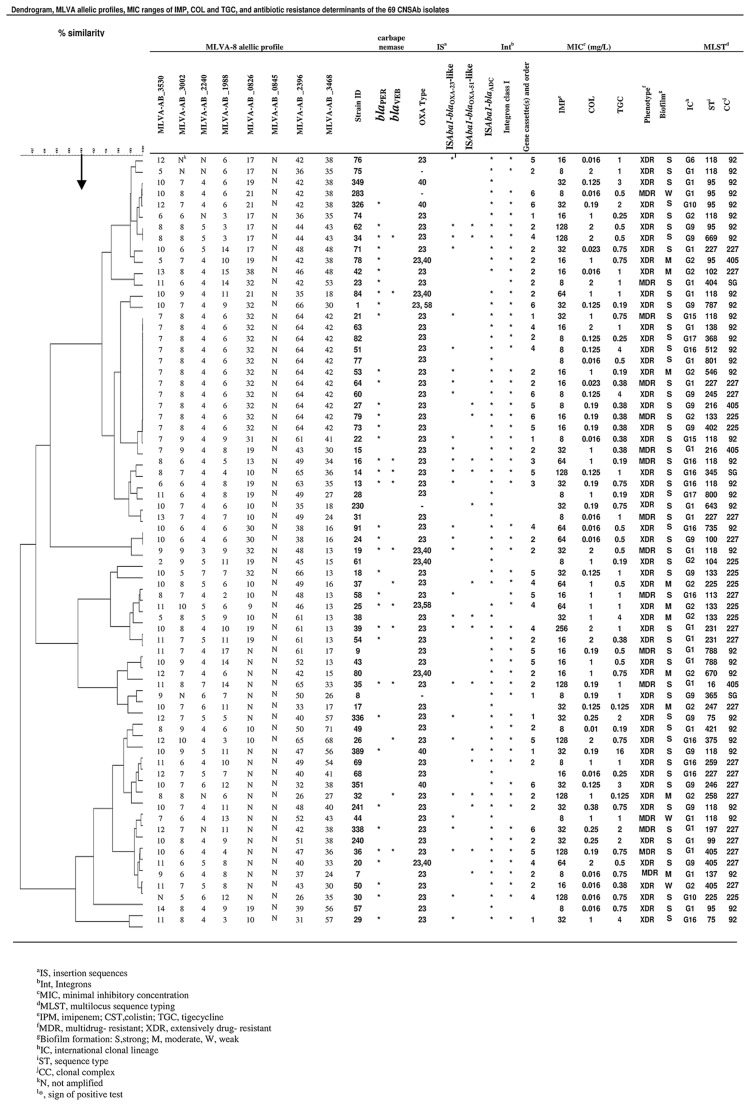
Dendogram shows the genetic diversity of 69 carbapenem non-susceptible Acinetobacter baumannii isolates by MLVA and MLST; carbapenemase encoding genes; MIC ranges of colisitin, imipenem, and tigecycline; resistance phenotype; biofilm formation and international clonal lineage.